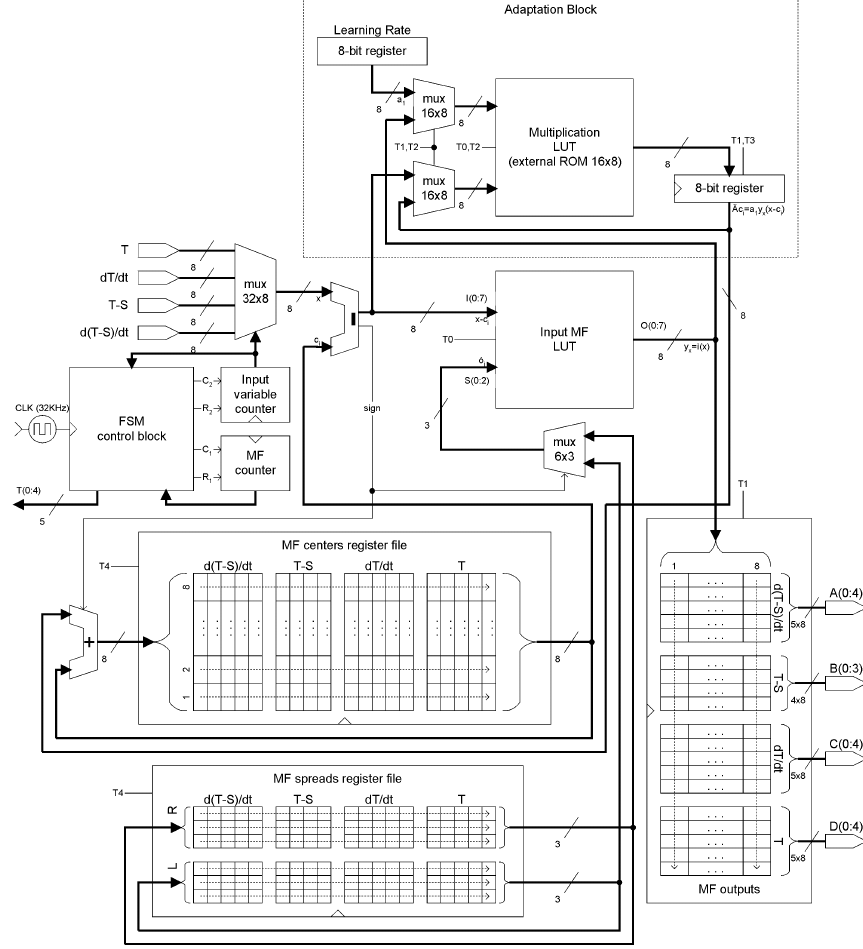
FIGURE 7 Fuzzifier block